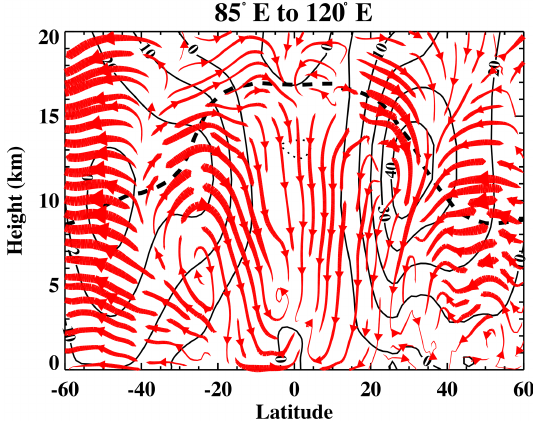
Figure 7. As in Fig. 5, but averaged between 85 and 120 ◦ E.